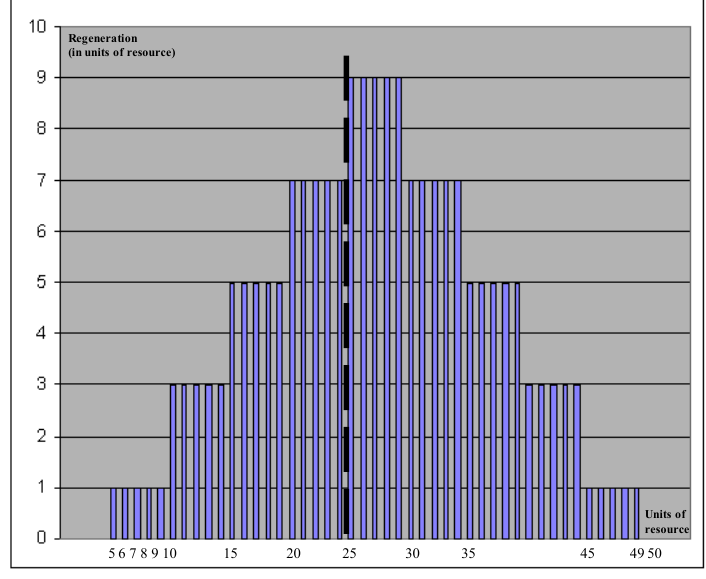
Figure 1: Resource dynamics scenario A (without threshold)